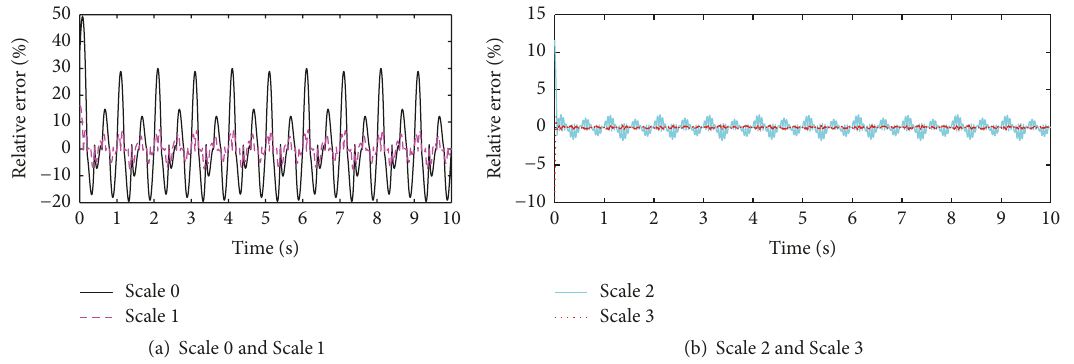
Figure 6: The reconstructed error in Case B1.